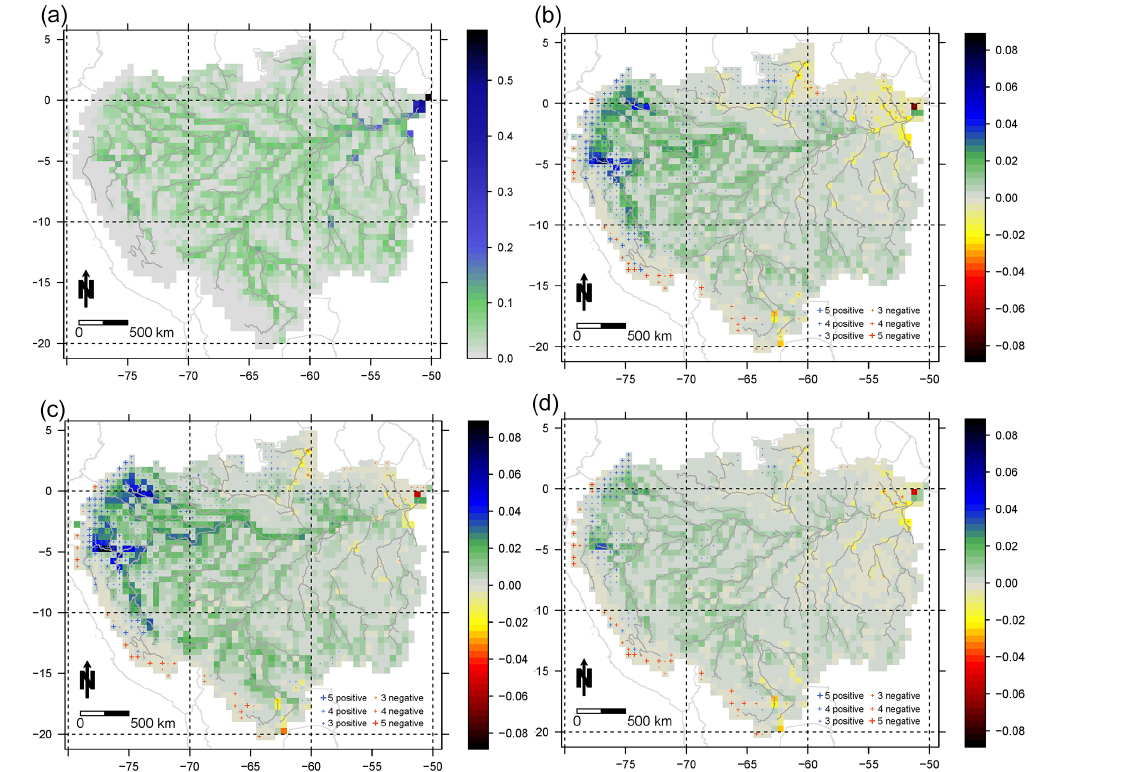
Figure 7. Proportion of outgassed carbon from the river to total outgassed carbon. Proportion of riverine outgassing to total outgassing of carbon (a) during the reference period (1971–2000) and the difference in this proportion between future (2070–2099) and reference period caused by climate change averaged over five climate models and scenarios in emission scenario A1B (b) , A2 (c) and B1 (d) ; positive values indicate an increase and negative values indicate a decrease in the future